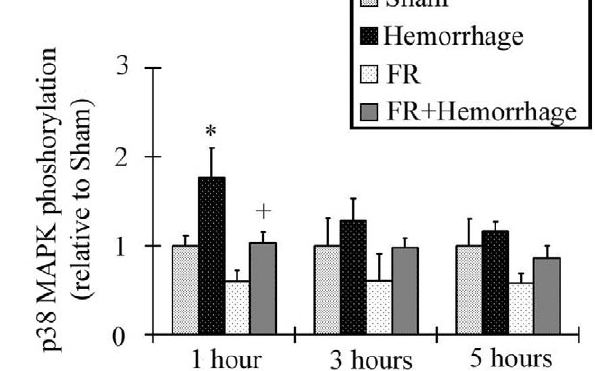
Figure 4. Changes in hepatic p38 MAPK activation after hemorrhage. The activation of p38 MAPK was assessed by Western blotting analysis. p38 MAPK phosphorylation levels, shown on the vertical axis in B, were determined after normalization using the density ratio of the phosphorylated p38 MAPK band (p-p38 MAPK in A) divided by the p38 MAPK band (p38 MAPK in A). Activation of p38 MAPK was significantly higher at 1 hour and returned to the baseline level at 3 hours after hemorrhage. Activation of p38 MAPK activation in the FR + Hemorrhage group did not change significantly at any time after a hemorrhage. Data are shown as mean 6 SE. n=5/groups, * p , 0.05 vs Sham, + p , 0.05 between Hemorrhage and FR + Hemorrhage.